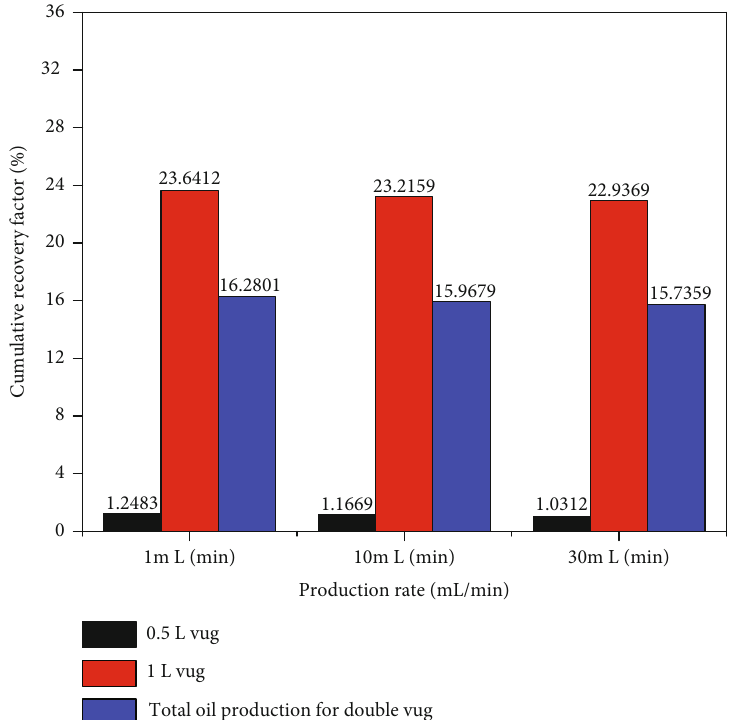
Figure 5: Column chart of cumulative recovery factor in high-pressure physical property experiments under connection type I (di ff erent production